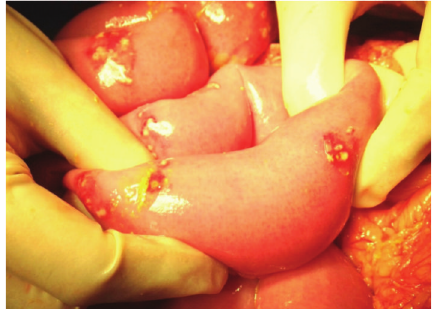
Figure 3: Each perforated site contained a confluence of pinpoint perforations.